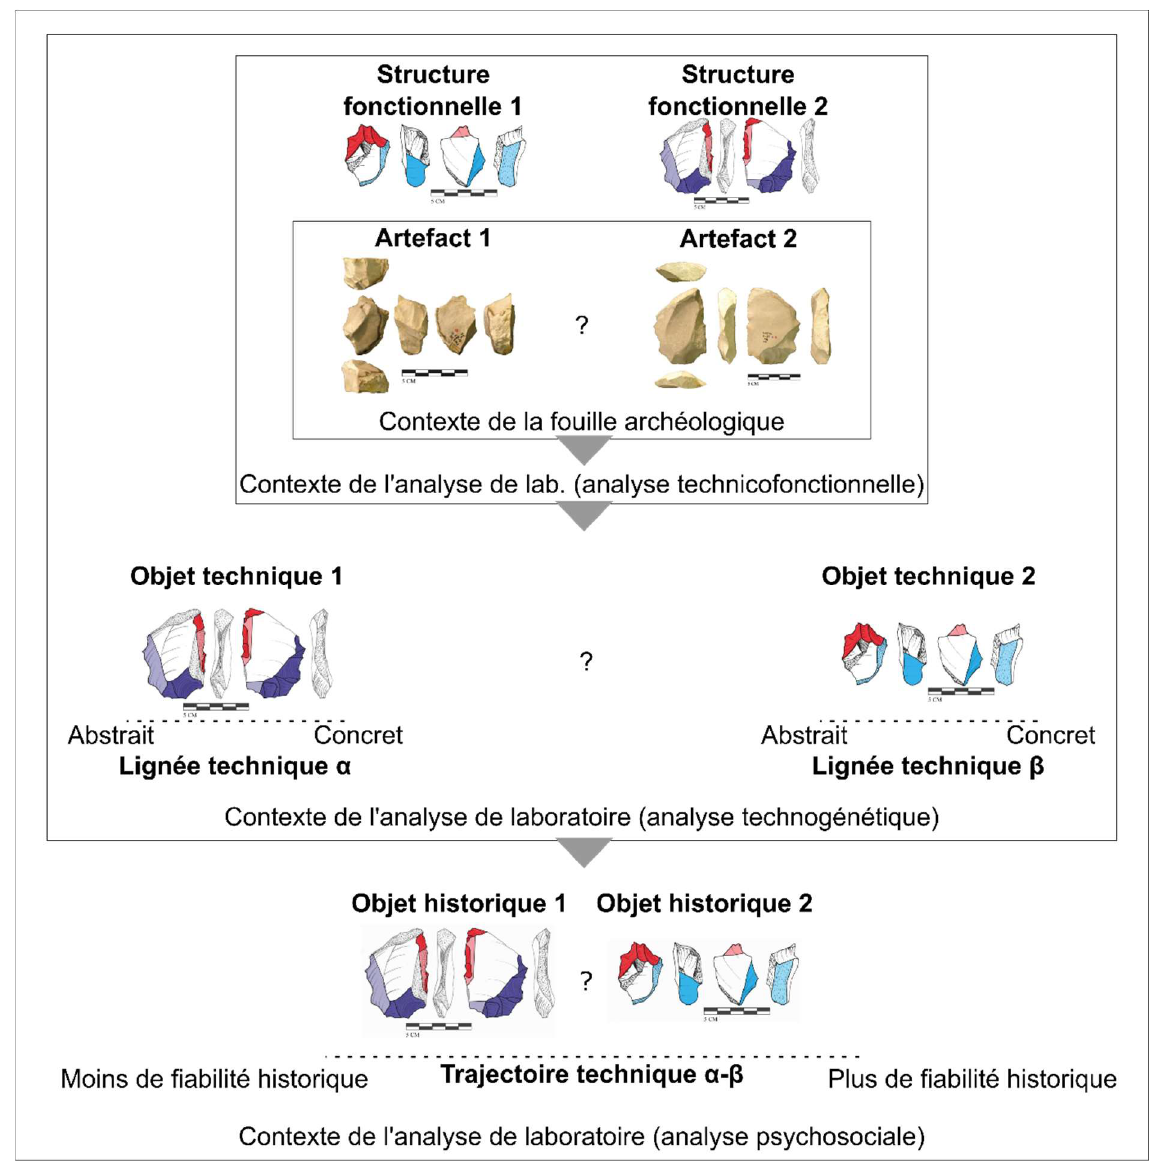
Figure 2. Relations techniques entre artefacts, structures et opérations, dans une technologie lithique qui suit les principes d'une épistémologie des